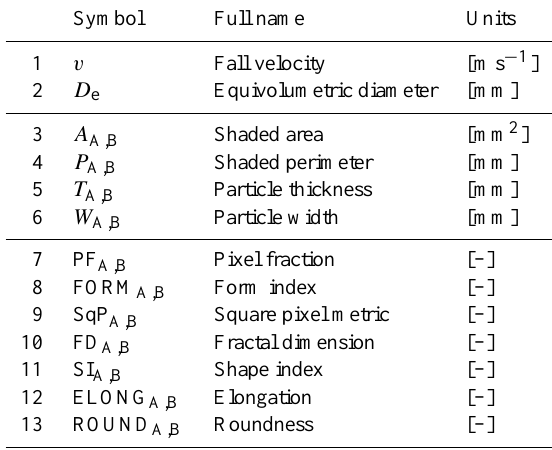
Table 1. List of descriptors chosen to describe the particles recorded. Descriptors 1 and 2 come from the combination of